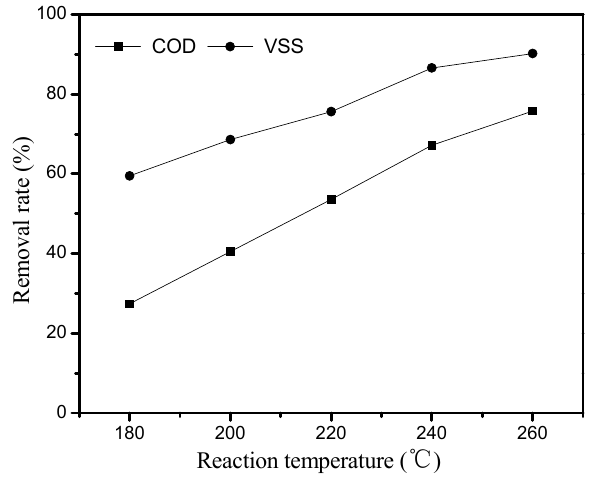
Figure 3. Effect of temperature on the COD and VSS removal rates (Time: 60 min; Catalyst: 0.5 g; Oxygen dosage: 1.0 MPa).